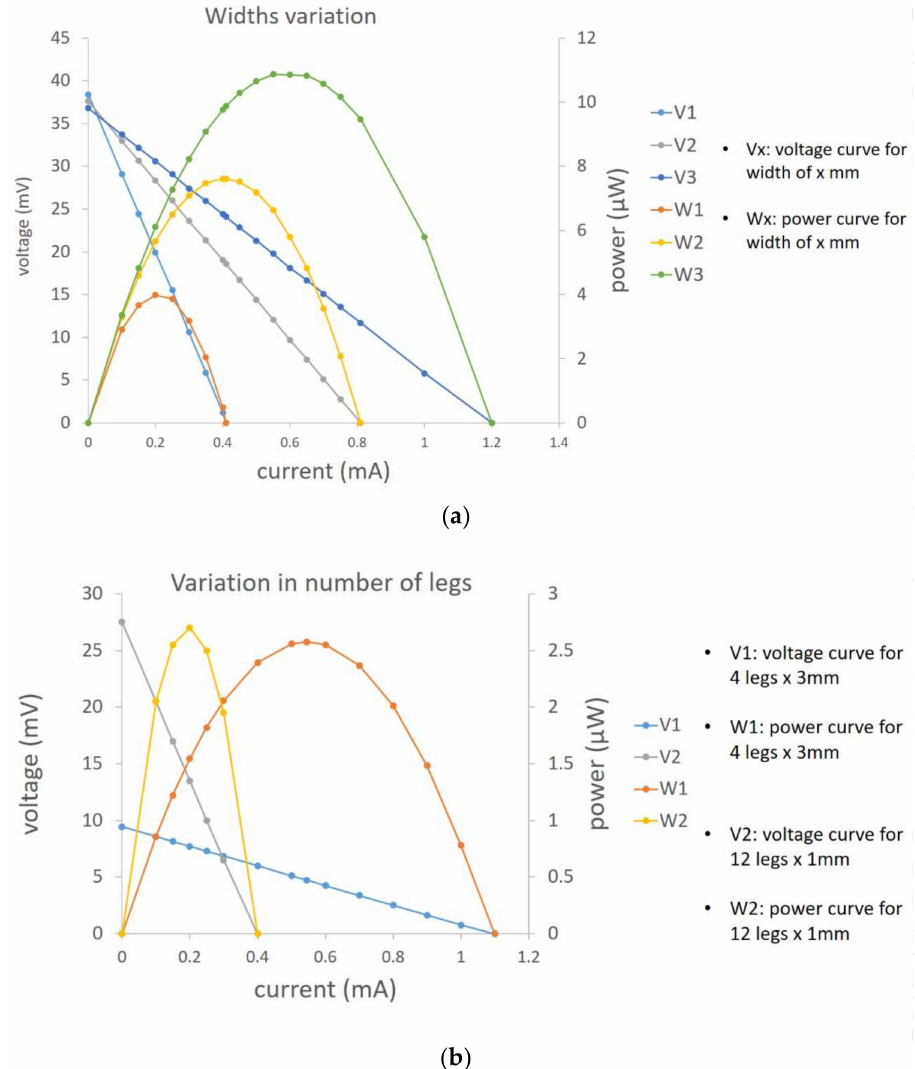
Figure 8. ( a , b ) Variation in leg’s widths and number of legs